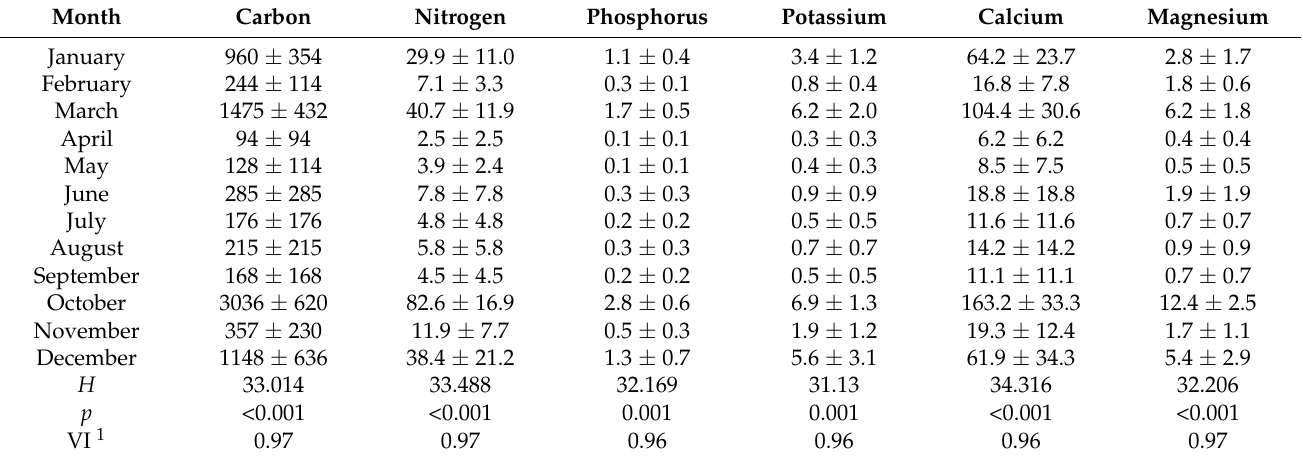
Table 3. The influence of month of year on macronutrient return (mg · m − 2 ) in Serianthes nelsonii fruit litter.